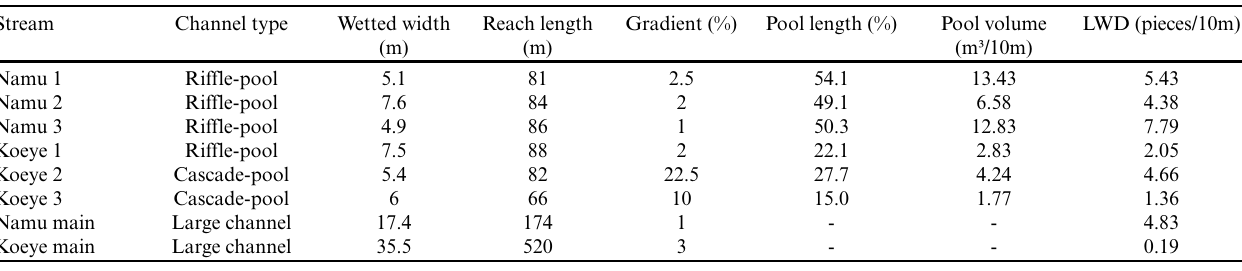
Table 1 . Reach level characteristics of the eight streams assessed in the Namu and Koeye watersheds. Large woody debris (LWD) density is given as the number of pieces per 10 m of reach length. Pool length is the percent of the reach length represented by pool habitats. Pool volume density is estimated based on the length x width x residual depth of all pools and averaged per 10 m of reach length. Pools were too deep to measure at Namu main and Koeye main.